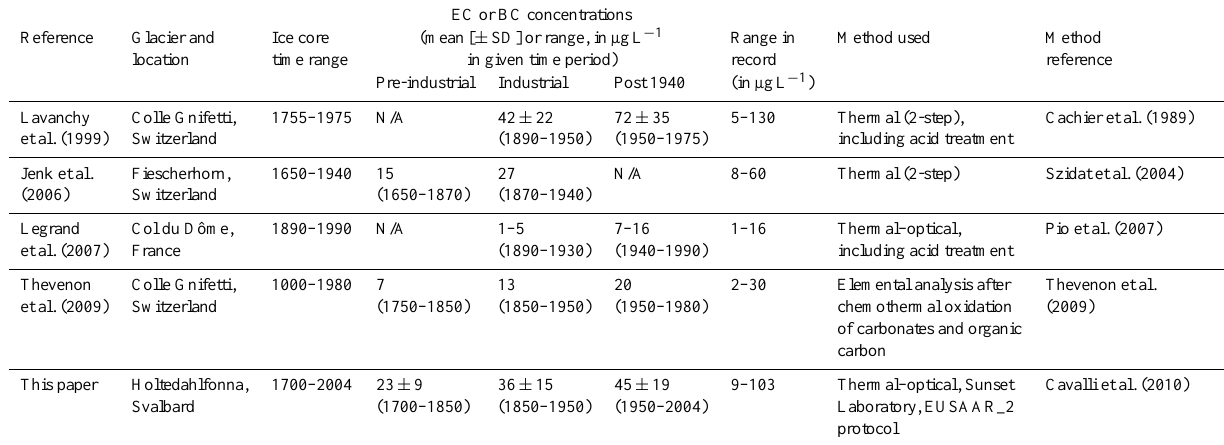
Table 1. EC or BC concentrations measured with filter-based thermal, thermal–optical or similar methods from the European Alps and Holtedahlfonna,